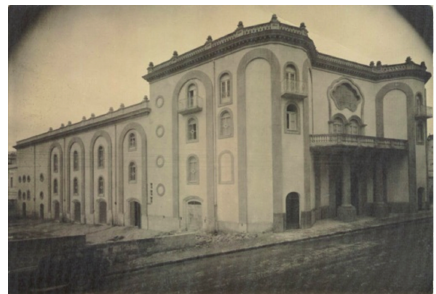
Figure 6: The “Centrone” theatre in Gravina in Puglia